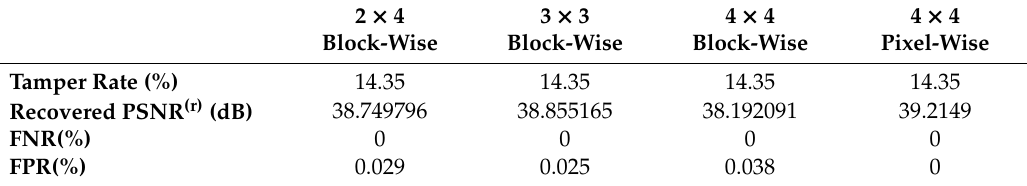
Table 7. Recovered PSNR (r) , FPR, and FNR results of the proposed method with complex images.